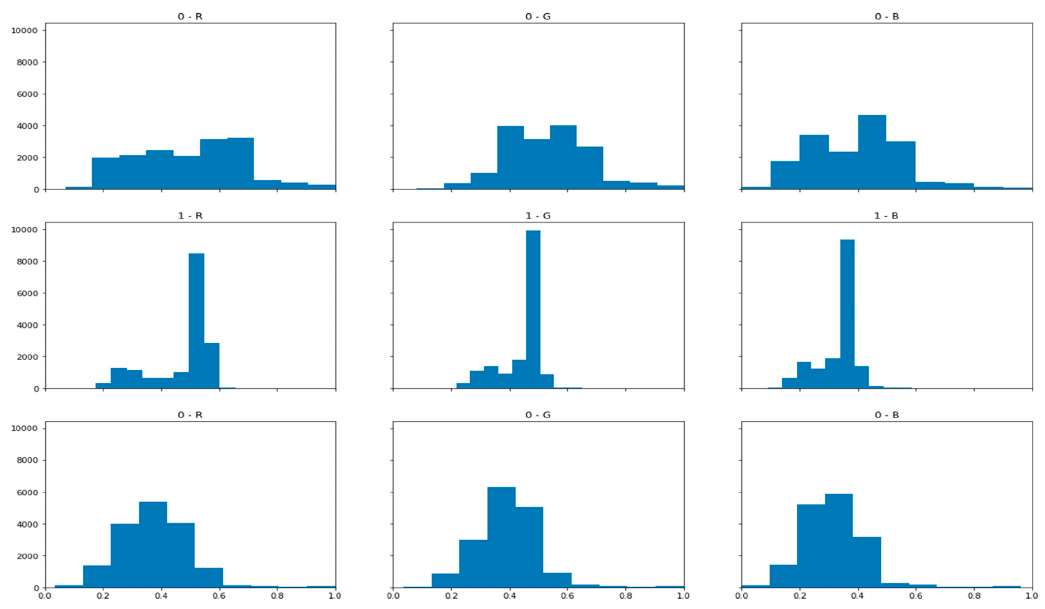
Figure 15. Histogram distribution of RGB components.